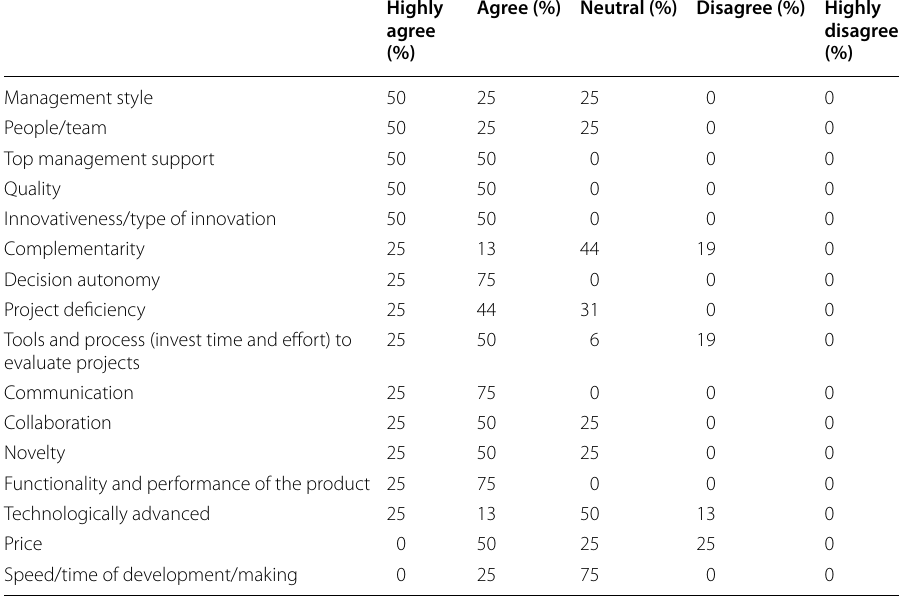
Table 4 Survey results in percentage of response related to product/project-related factors